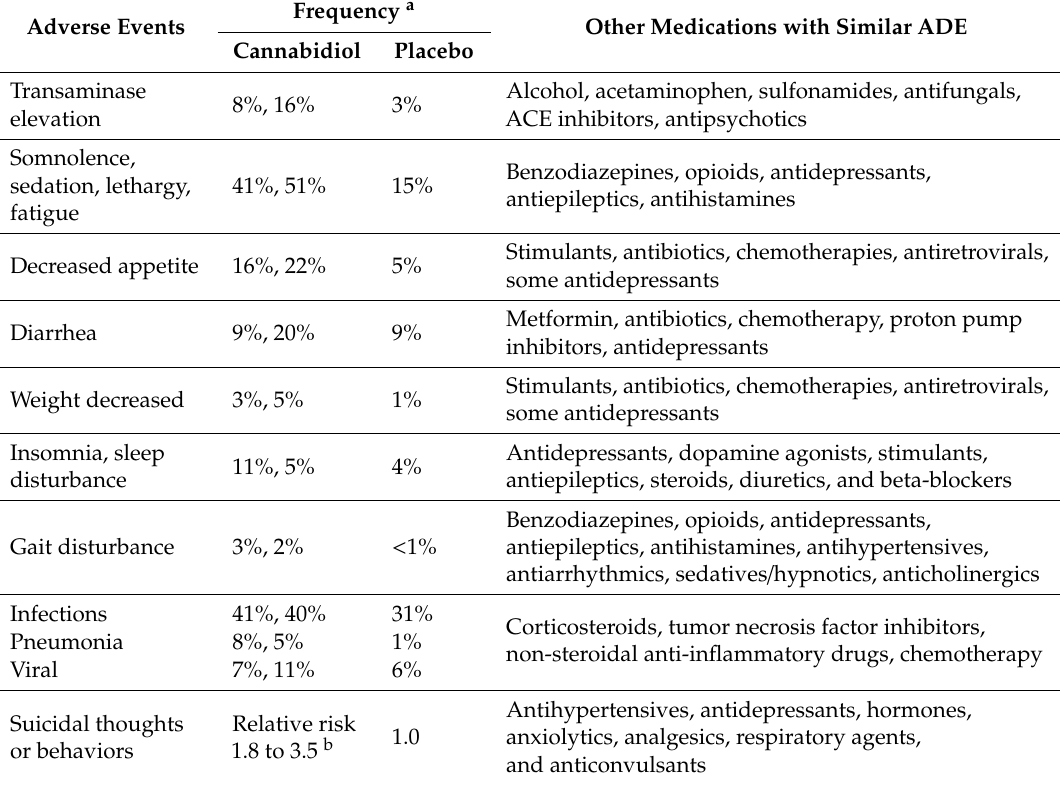
Table 4. Adverse events reported in clinical trials of cannabidiol